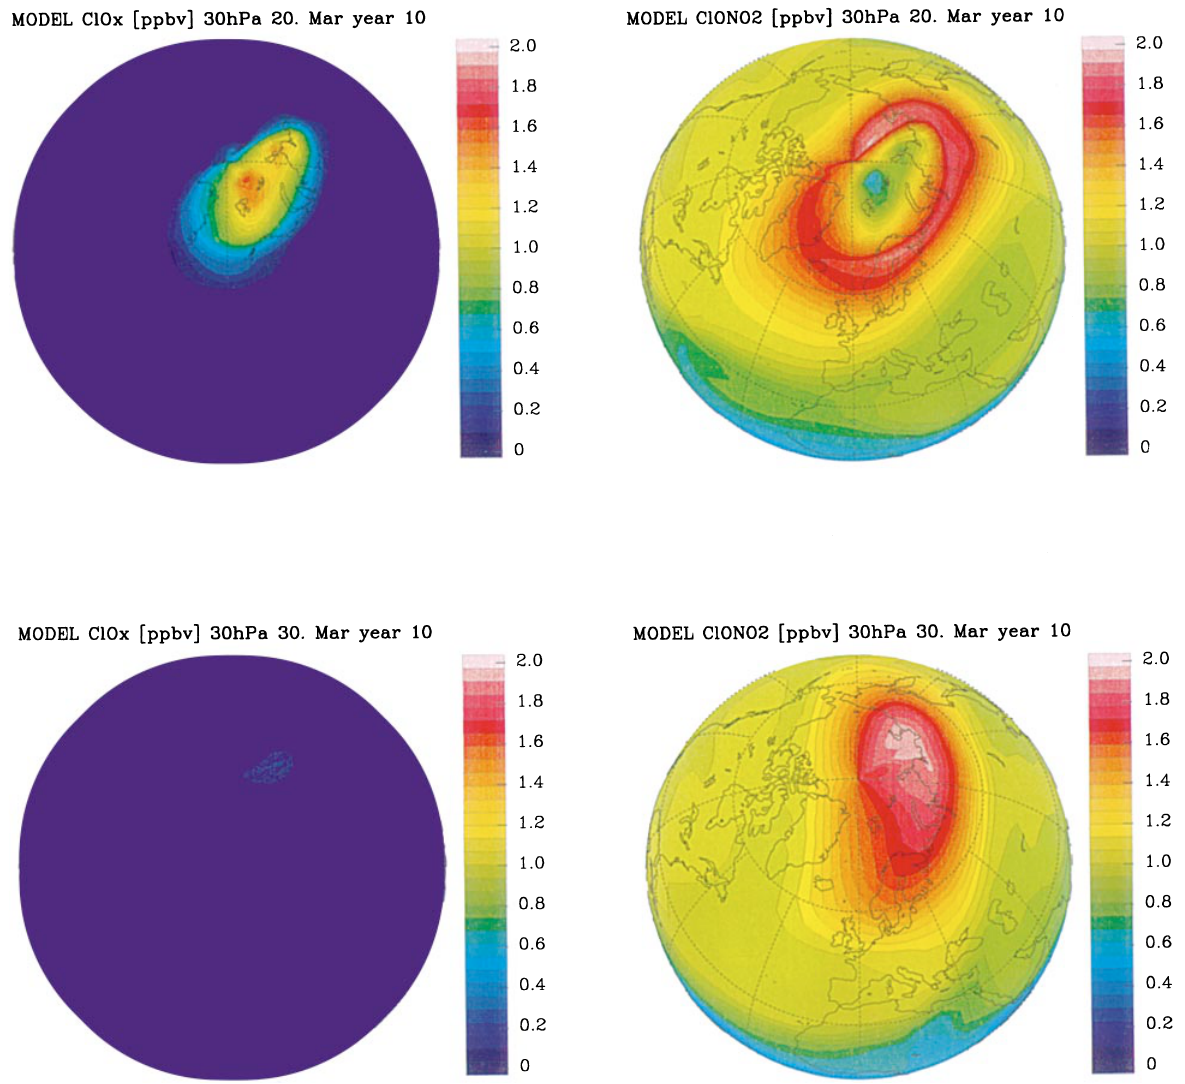
Fig. 8. Northern-hemisphere charts of ClO of model year 10 (both in ppbv)